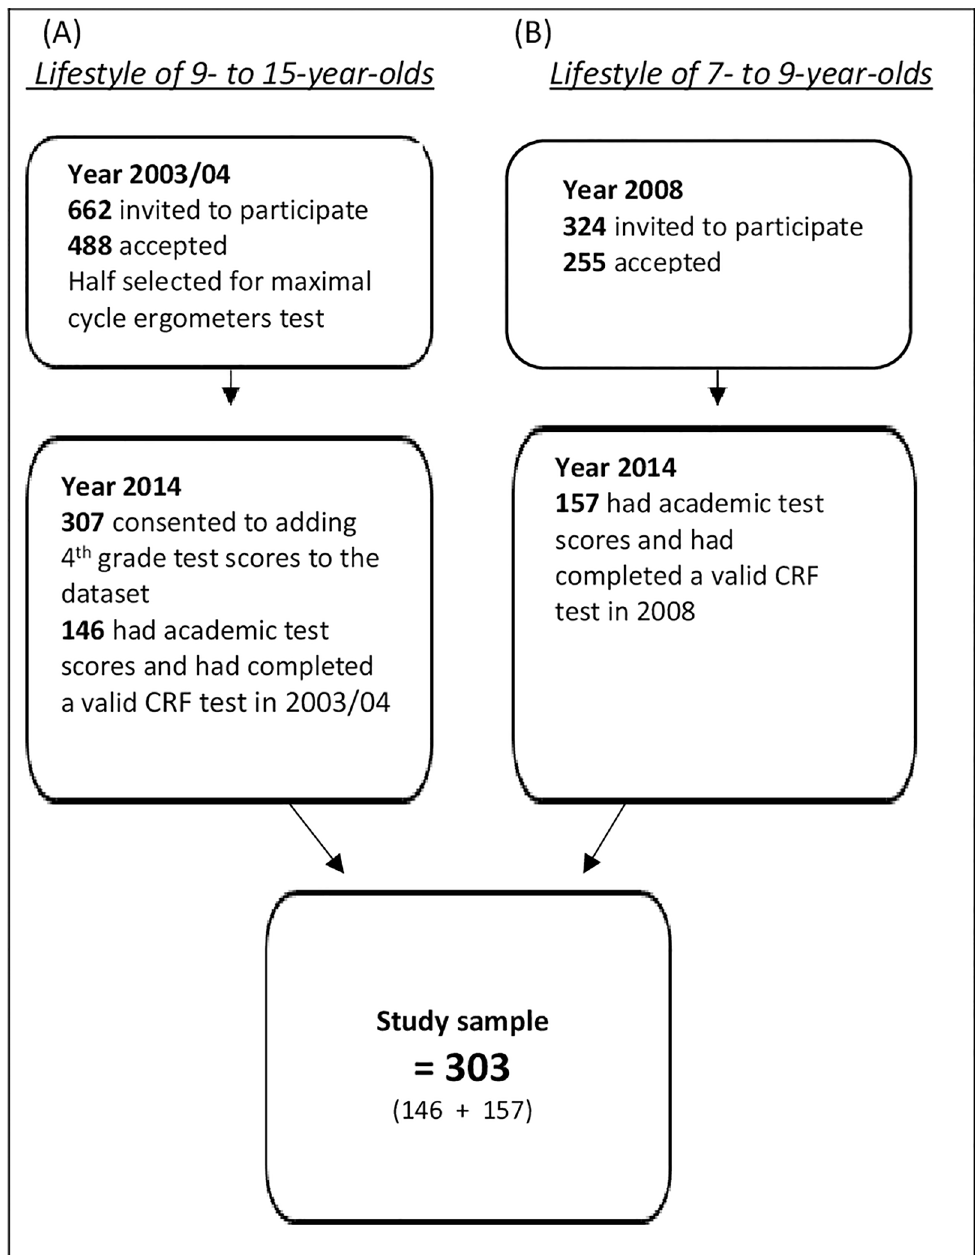
Fig 1. The origins of the study sample. Participants came from two different study cohorts, “Lifestyle of 9- to 15-year- olds” and “Lifestyle of 7- to 9-year-olds.” The participation rate, inclusion criteria and total number of participants are